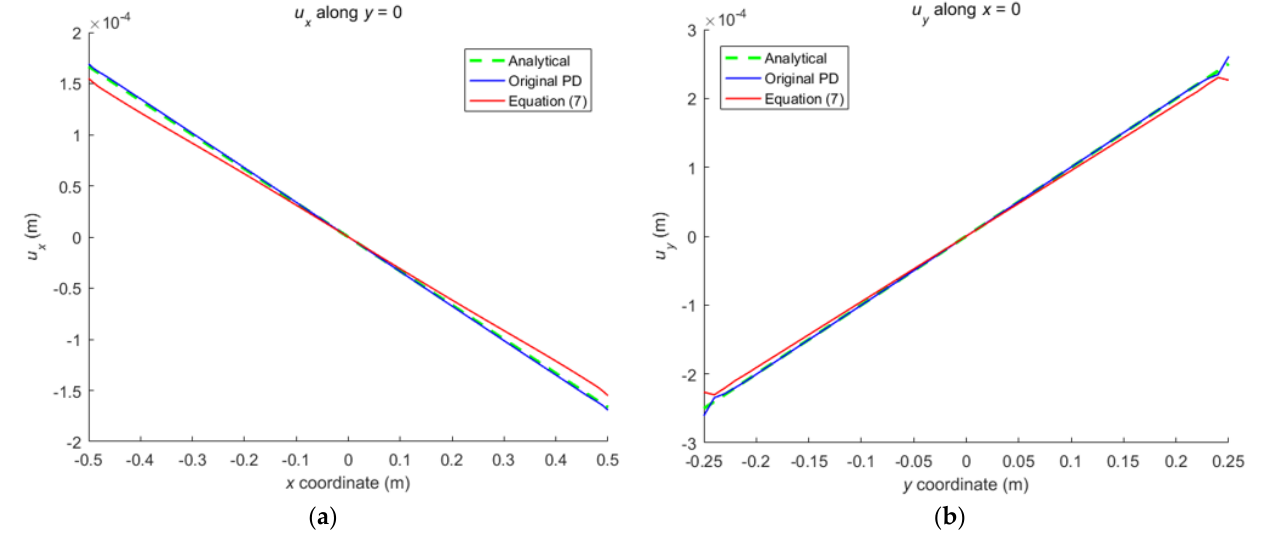
Figure 8. The displacement along the bottom side and left side of the rectangular plate subjected to tension: ( a ) u x along y = − 0.25 m; ( b ) u y along x = − 0.5 m.